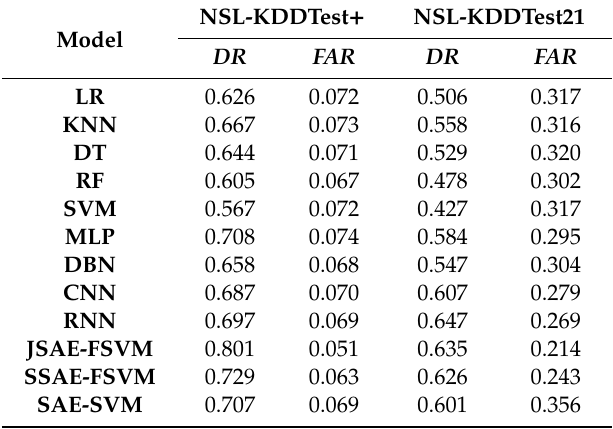
Table 6. Comparison of the proposed model and the basic models in terms of detection rate ( DR ) and false alarm rate ( FAR